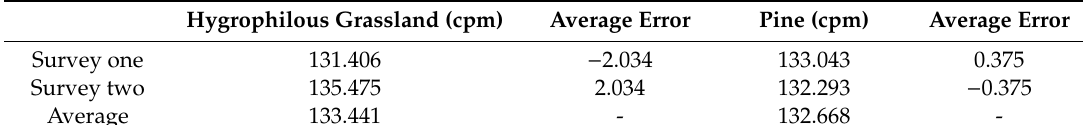
Table 2. Calculated calibration ( N 0 ) values.